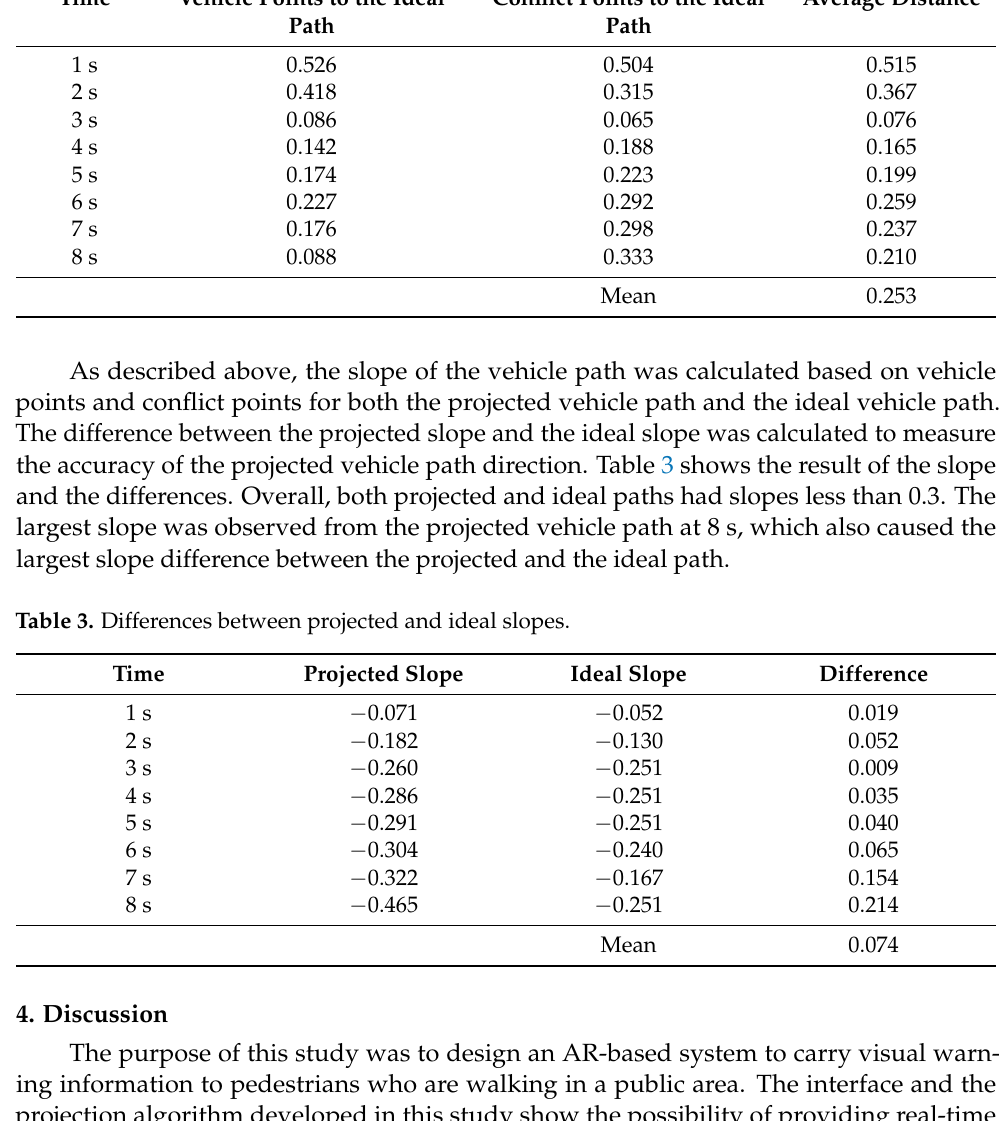
Table 2. Distance between projected points and ideal points. Distance from Projected Time Vehicle Points to the Ideal Path